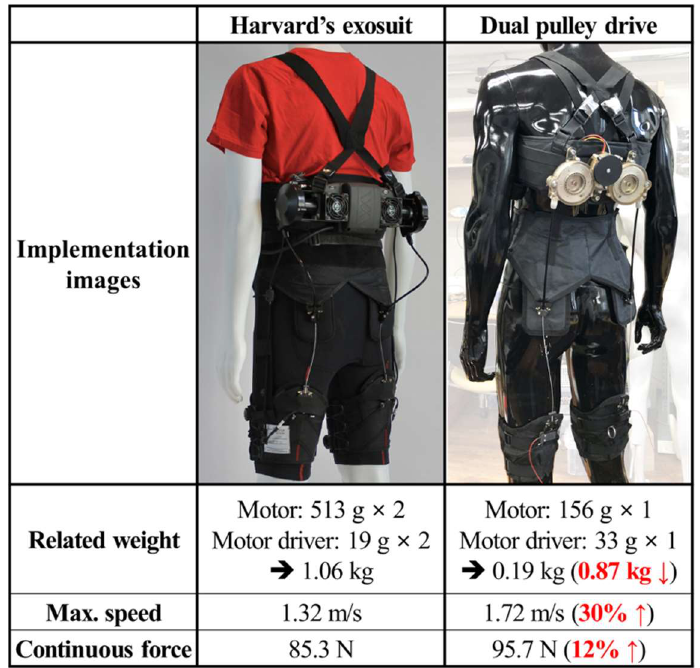
Figure 9. Comparison of the dual pulley drive and state-of-the-art exosuit developed by Harvard University.